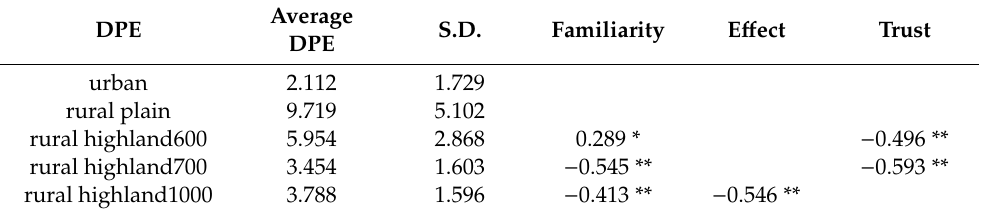
Table 5. Pearson’s correlation analysis among perception factors and Daily PM 2.5 Exposure (DPE).